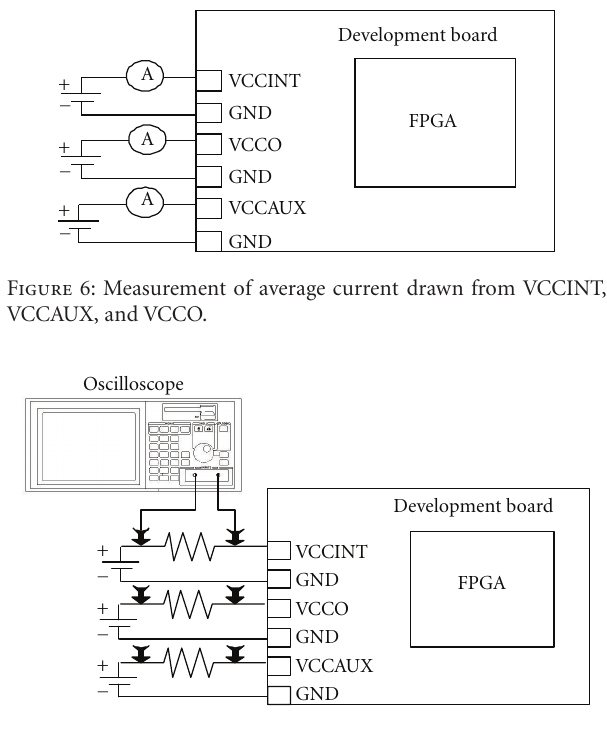
Figure 7: Measurement of current drawn during reconfiguration occurrences.